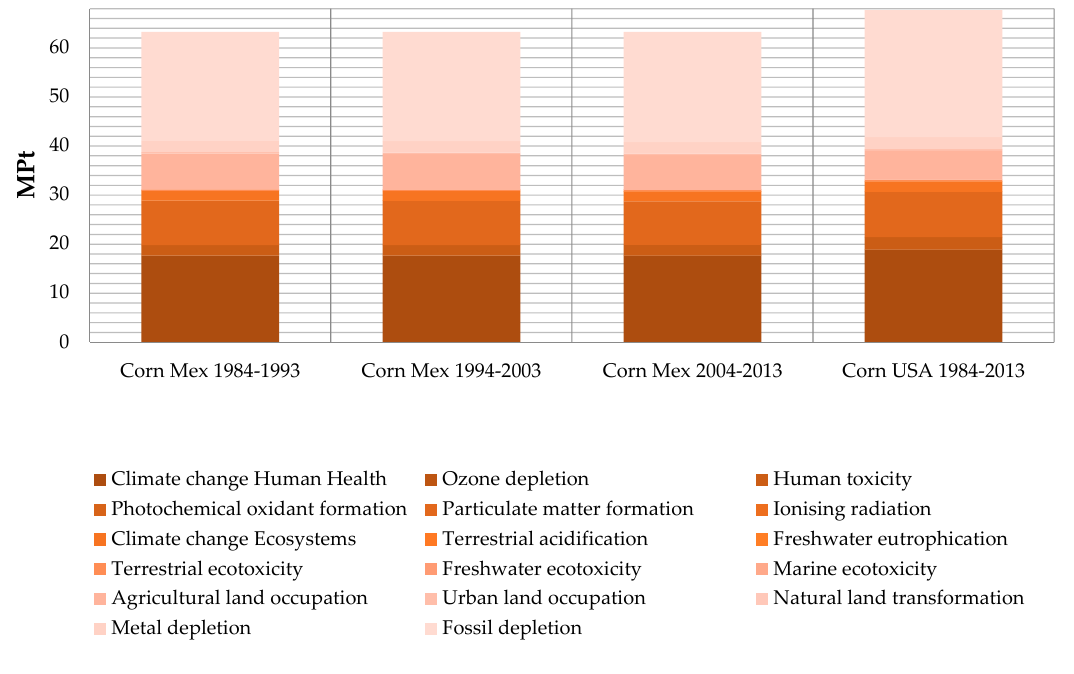
Figure 3. MP Graph by impact category normalized by functional unit by the ReCiPe Endpoint (H) V1.10/World ReCiPe H/H/single-score method.